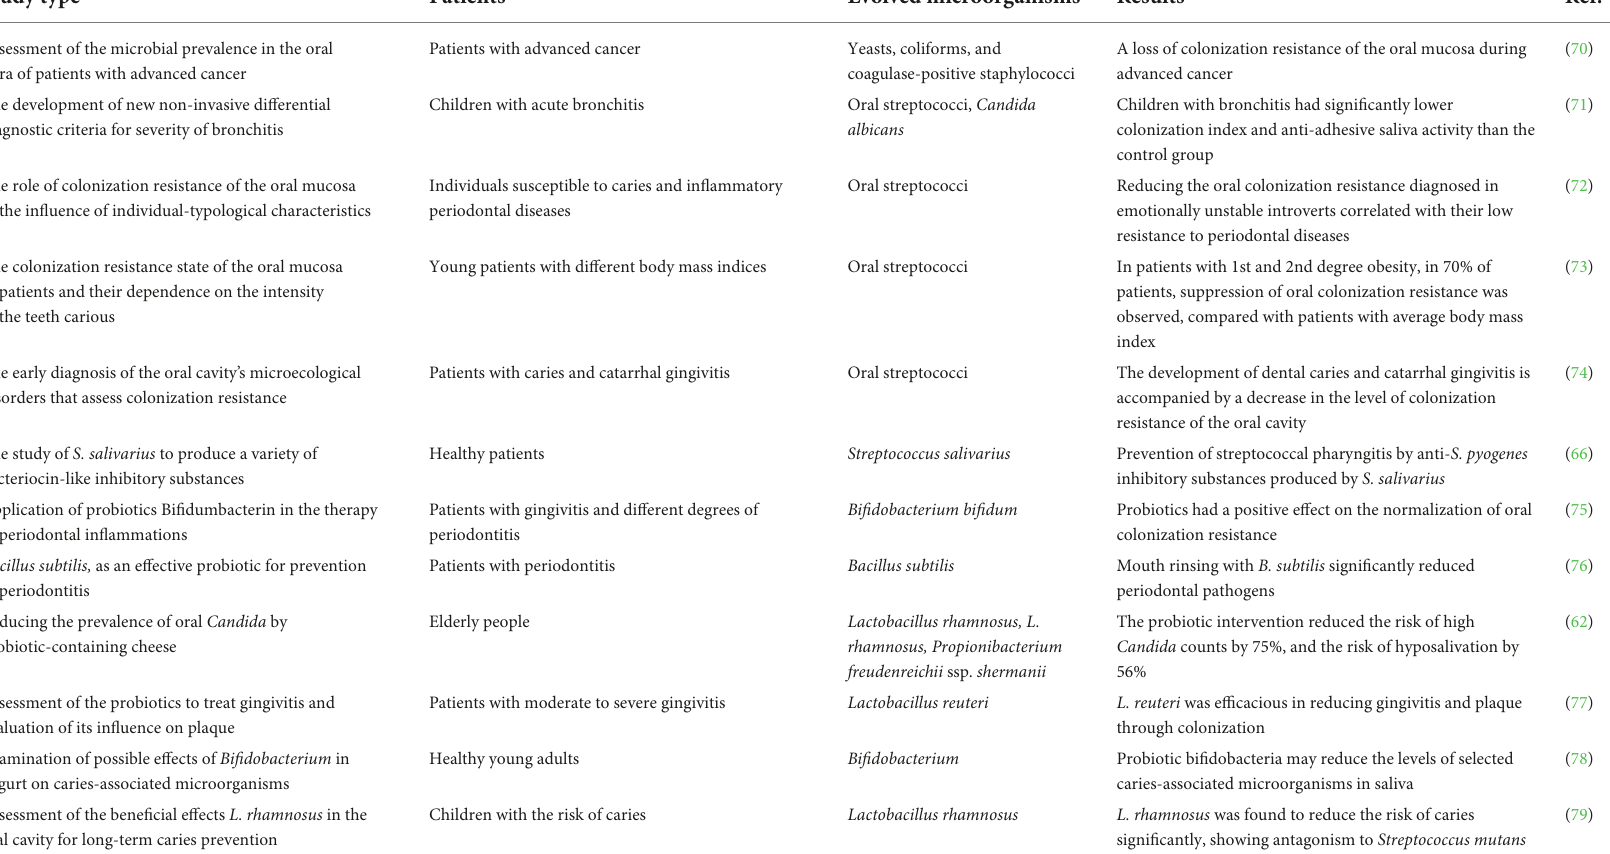
TABLE 1 Clinical studies to assess the significance of colonization resistance of the oral